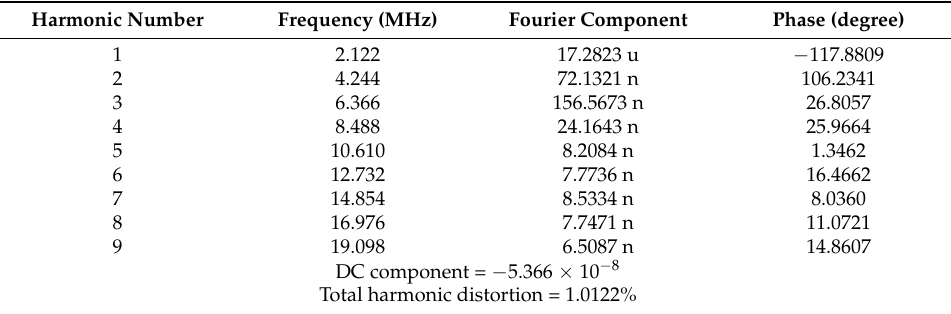
Table 7. Total harmonic distortion analysis of I o 2 in Figure